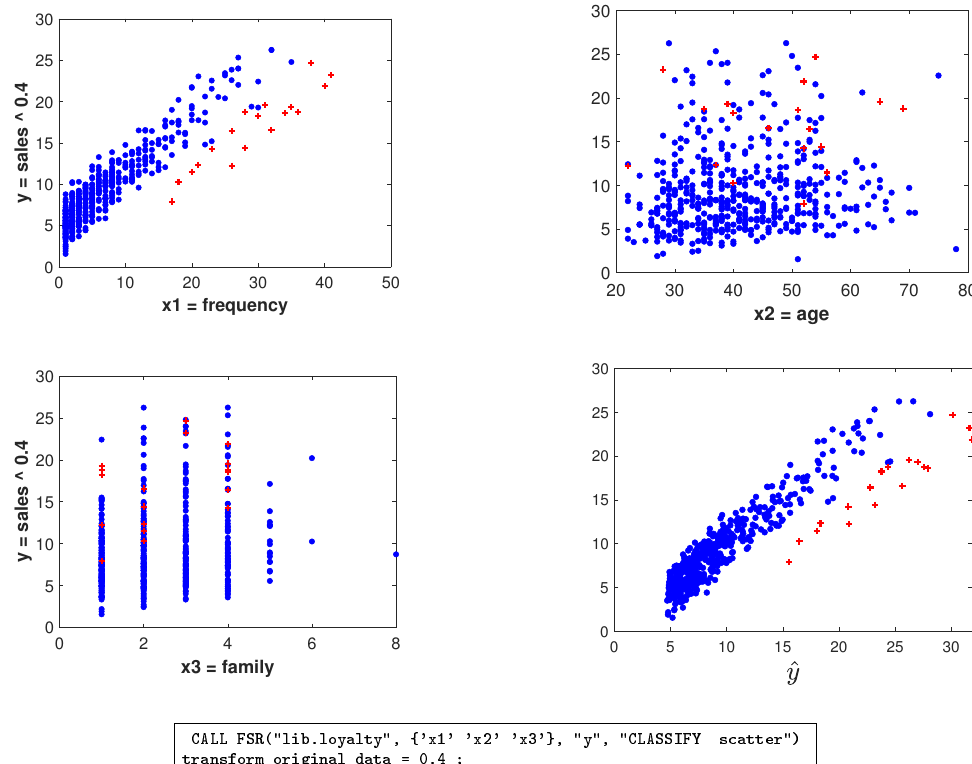
Figure 4. Loyalty card data: scatterplots of transformed data when λ = 0.4, with the 18 outliers detected plotted as red crosses (in the online .pdf version). Last panel: a plot, suggested by a referee, of the fitted values on the horizontal axis and the response on the vertical axis. The box under the figure contains the SAS code used to generate the scatterplots.